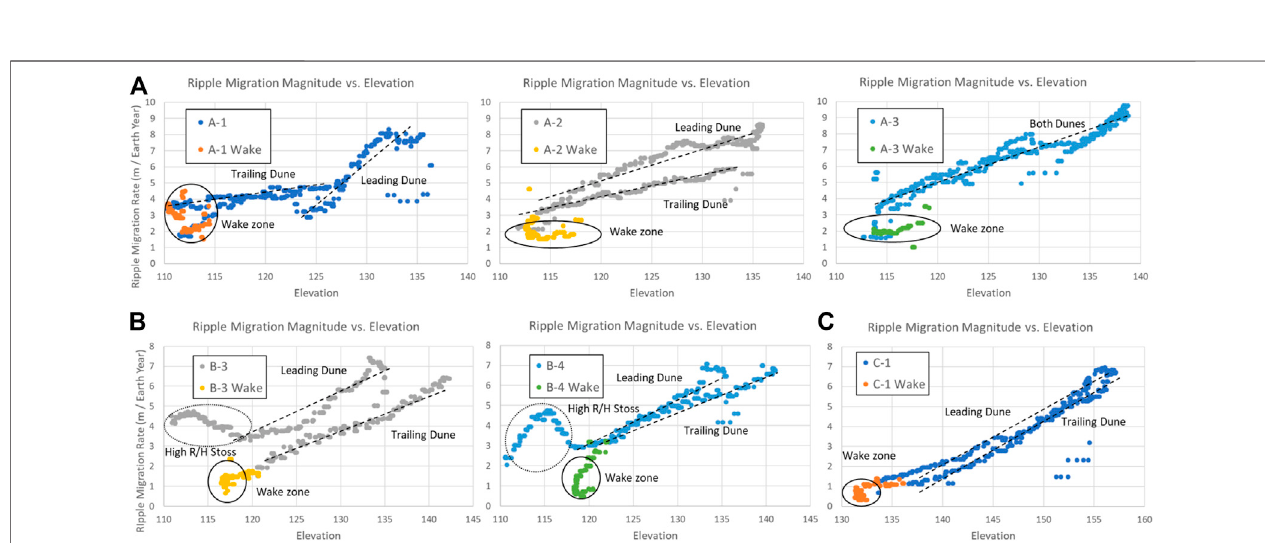
FIGURE9| Ripplemigrationmagnitude(R)vs.elevationforselectedtransectsonDunes (A-C) .Elevationisusedhereinsteadofduneheighttoavoidissuesarising from either the arbitrary selection of datum or the interpolation of bedrock elevations used to determine dune height in some analyses. These plots show that the wake zones (highlighted in each plot) plot distinctly from the overall linear trend expected for these dunes as highlighted by the dashed lines. In most cases the wakes plot as low-magnitude clusters or follow linear trends offset from the leading and trailing dunes in each dune study area.